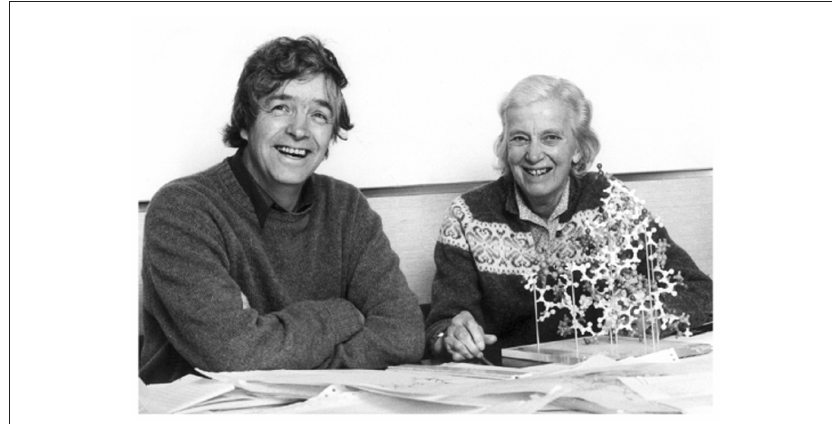
Figure 1 | guy Dodson, Dorothy Hodgkin, and the insulin molecule. Picture courtesy of Eleanor